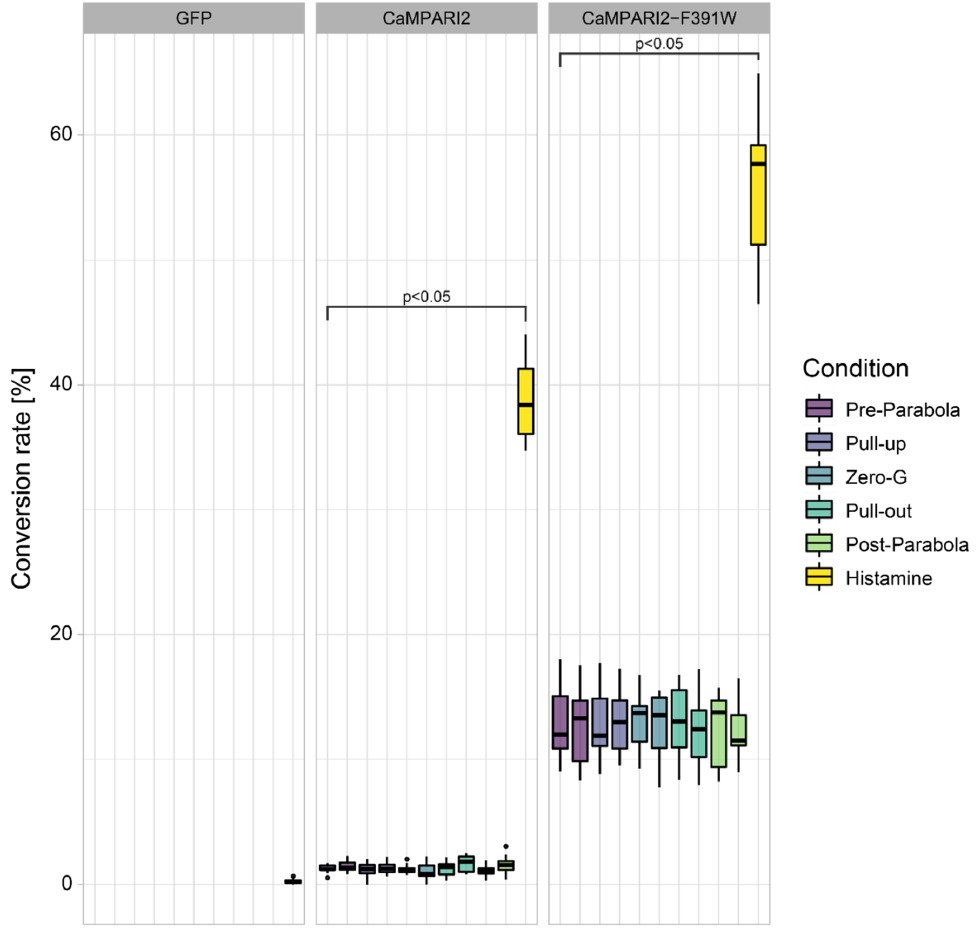
Figure 4. Conversion rates of C28/I2 human chondrocyte cells expressing GFP, CaMPARI2, or CaMPARI2-F391W. The cells were illuminated for 8 s with 405 nm light during the indicated flight phase for conversion. The cells expressing GFP were illuminated directly before each Pre-Parabola phase. For each parabola and CaMPARI2-construct, eight wells per 96-well plate were treated with 100 µ M histamine for 15 s and subsequently illuminated for 8 s. The conversion rate was calculated using the mask described in 2.10. Brackets indicate significant differences compared to the Pre-Parabola phase ( p < 0.05 using ANOVA and Tukey posthoc